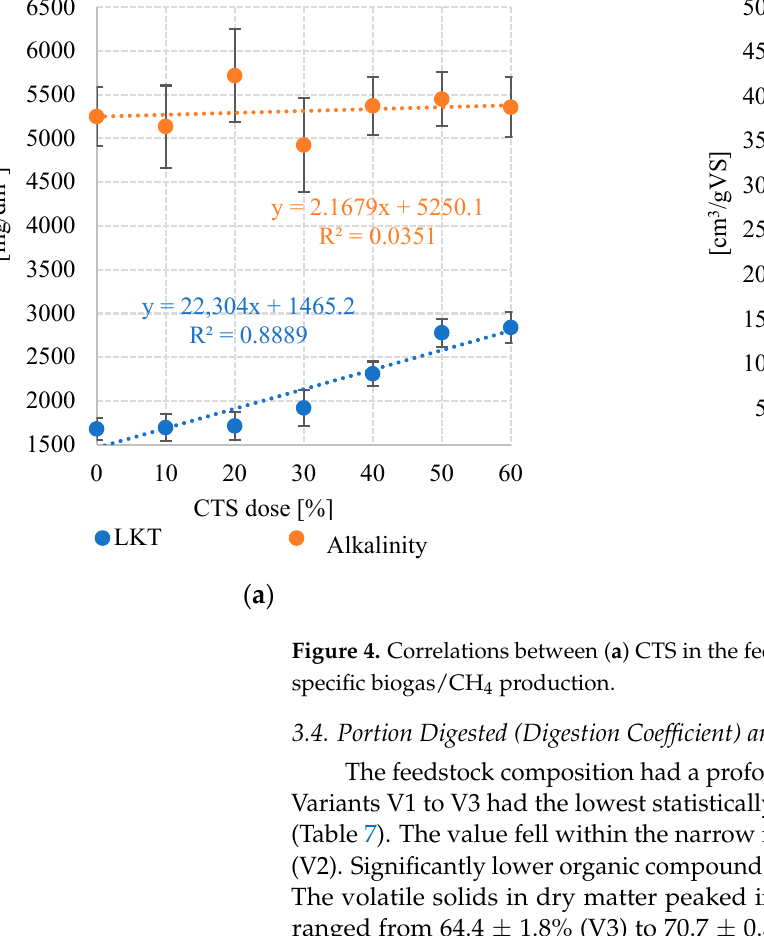
Table 7. TS, VS and fertilizing substances in the digestate (by